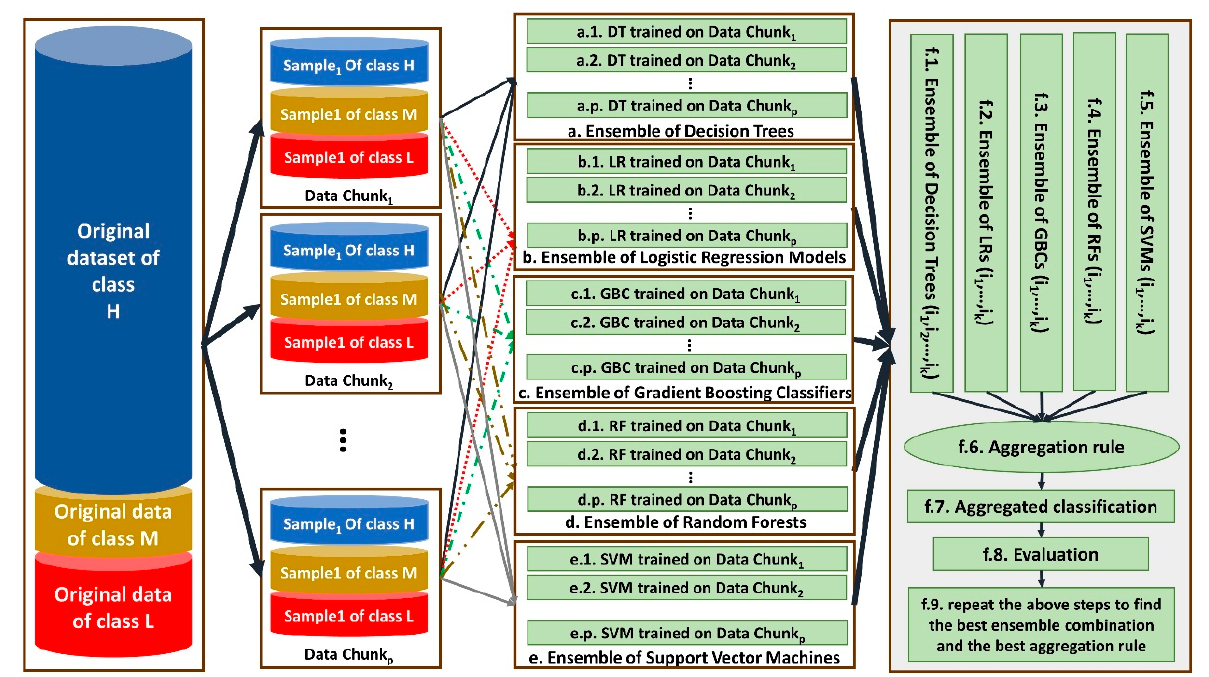
Figure 3. The architecture of our proposed distributed ensemble classifiers for Apgar score predic- tion.